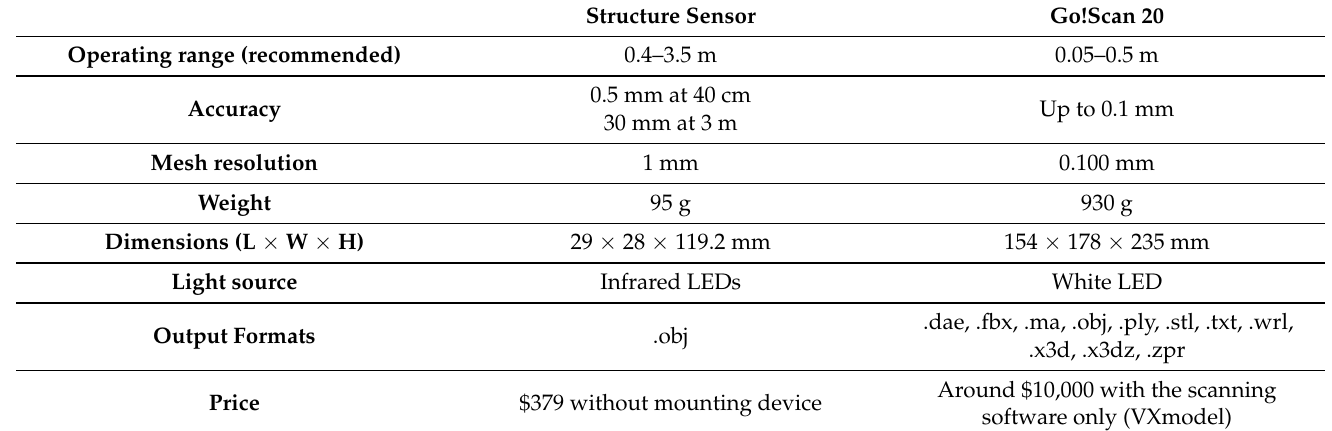
Table 2. Technical comparison between the Structure Sensor [26] and the Go!Scan 20